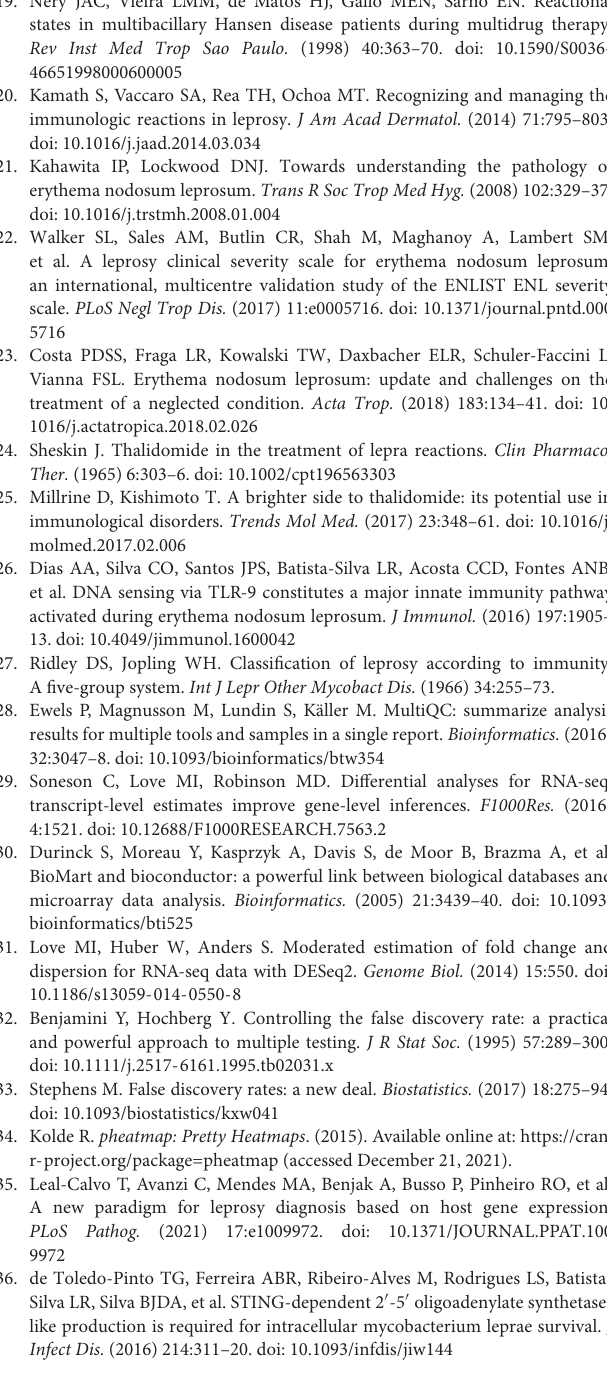
versus frontal dispersion measured by height (FSC-H, forward scatter-height). The PBMC region was selected by FSC-A and lateral dispersion measured by SSC-A area (side scatter). In the region of PBMCs, pDCs were identified as CD11c − , CD123 + and BDCA2 + . The expression levels of TLR9 and TLR7 by pDCs are shown in the representative histograms. HD, healthy donor; NR, non-reactional multibacillary patient, ENL, erythema nodosum leprosum; and FMO, fluorescence minus